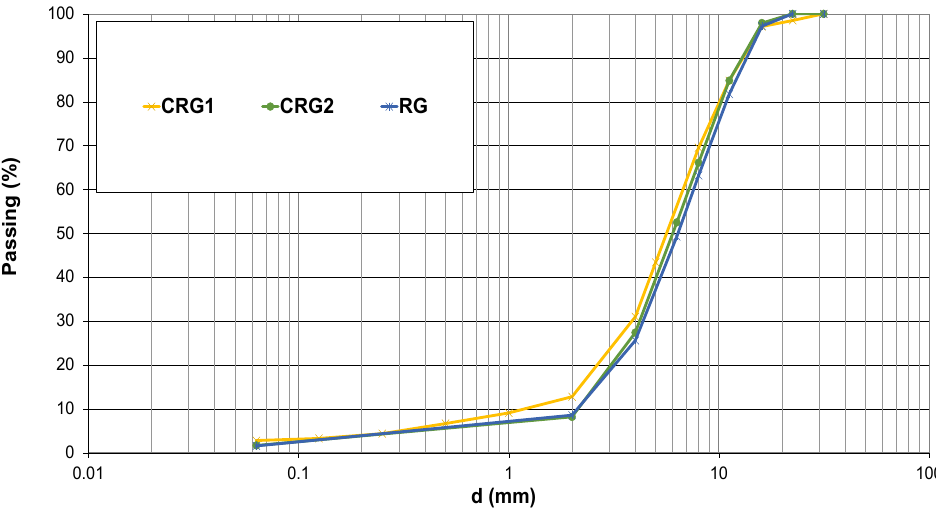
Figure 1. Sieve size curves of recycled sand before and after carbonation according to the two processes; d is the sieve size (passing).